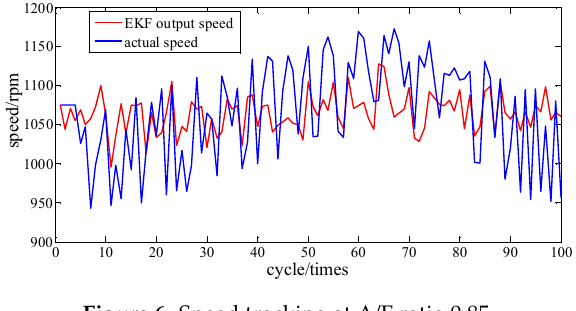
Figure 6. Speed tracking at A / F ratio 0.85.